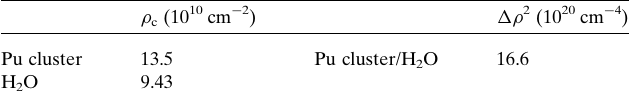
Table 2 Simulated results of SAXS diagrams obtained with SasView software.